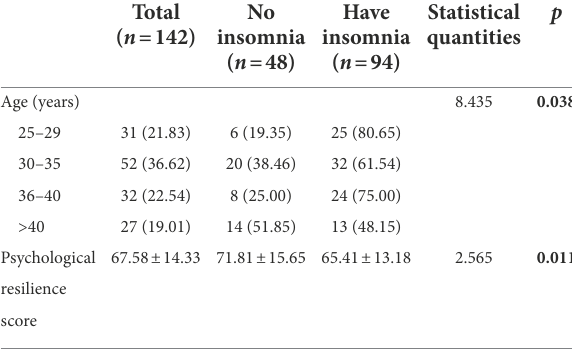
The bold value represents statistically